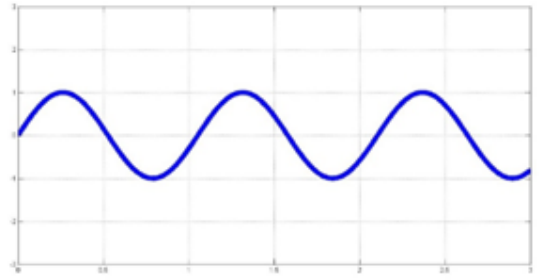
Figure 4. Third sinusoid signal is y